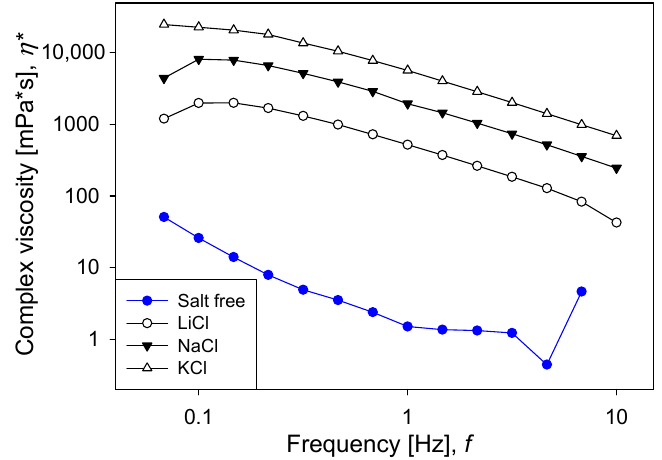
Figure 6. Effect of salt type on dynamic moduli as a function of frequency for silica suspensions formulated at natural pH. Salt concentration is 0.5 M.